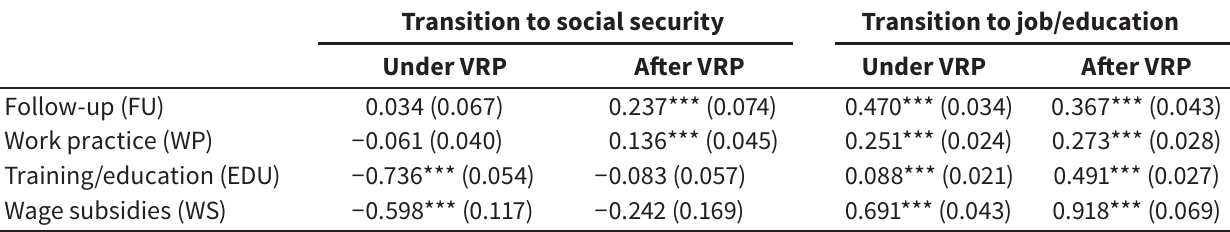
Effect of vocational rehabilitation programs (VRPs) during and after program participation on the transition to social security and